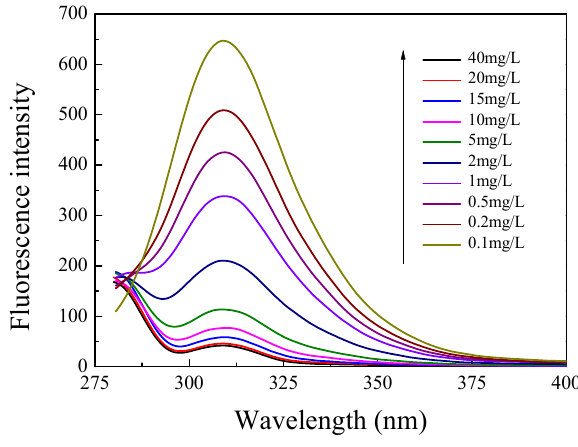
Figure 1. The typical fluorescence responses to different BPA concentrations.